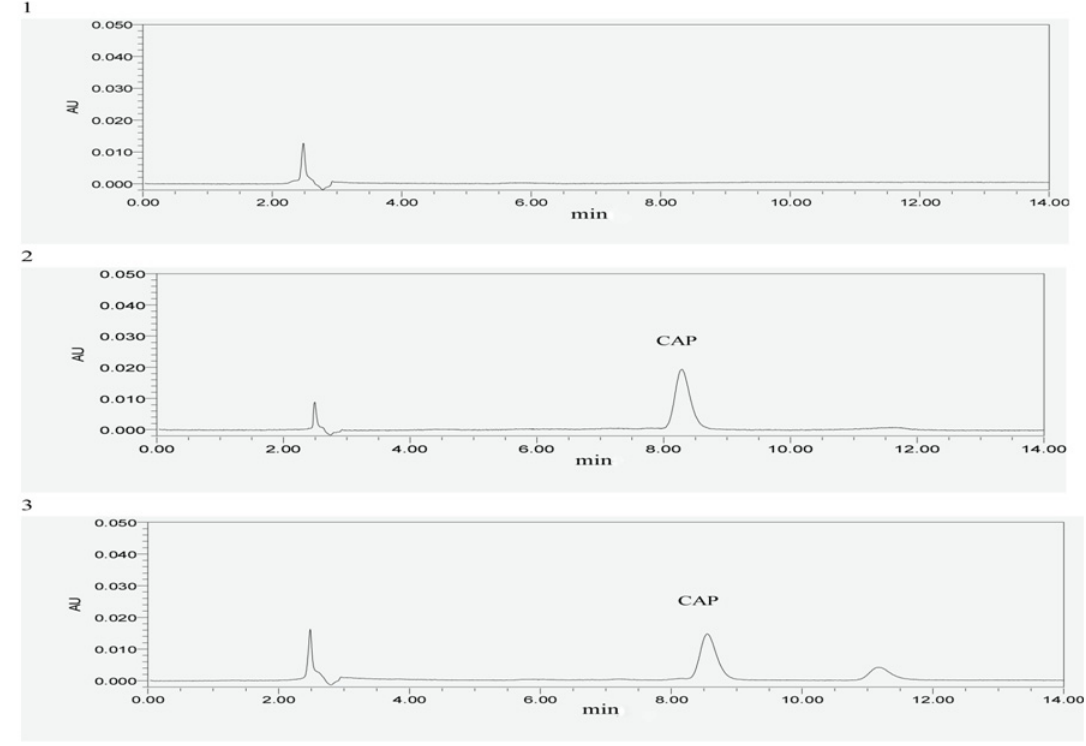
Figure 2. HPLC chromatogram of specificity investigation; 1 : the negative control (an enteric coated tablet without CAP); 2 : standard substance of CAP; 3 : sample of CAP. Abbreviations: CAP, capsaicin.